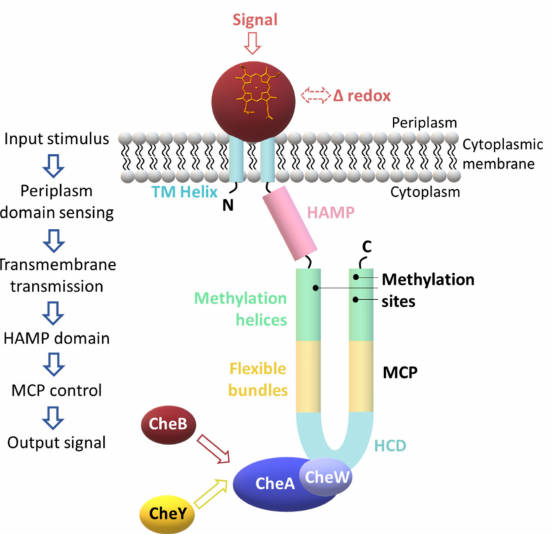
Figure 11. Proposed sensing mechanism of G. sulfurreducens heme MCP sensors. The periplasmic domain senses the external signal, which might be related with the redox sensing and transfers the signal through the TM helices, activates the HAMP domain and then the MCP. Then, the highly conserved signaling domain (HCD) is activated and regulates the ratios of CheW/CheW~P and CheA/CheA~P (see also Figure 10). The response regulators involved in chemotaxis, CheY and CheB, compete for CheA binding. CheY interacts with the flagellar motors and controls the direction of the motor rotation, while CheB demethylates specific and highly conserved segments located in MCP (methylation sites), thus controlling the adaptation for a ligand-bound receptor complex.